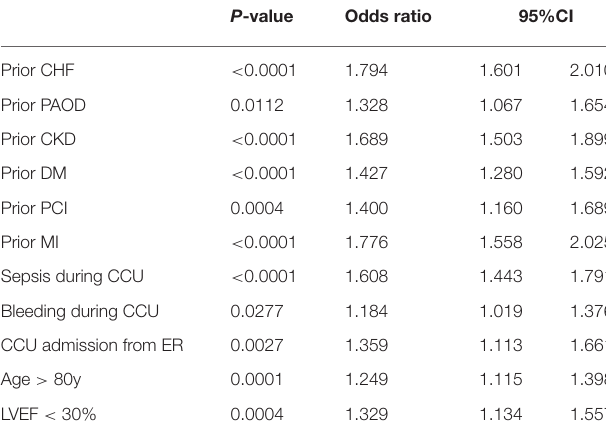
TABLE 2 | Multivariable analysis for